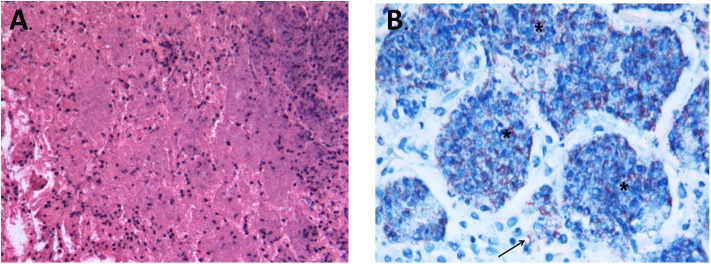
(A) Representative image of pulmonary necrosis in animals infected by strain 46P on day 28 postinfection. The image shows the complete loss of pulmonary tissue architecture over large areas, with cellular debris, picnotic and fragmented nuclei and acidophilic material occupying the extracellular space (200X magnification). (B) Ziehl-Neelsen stain showing specific necrotic areas with the presence of large ammounts of acid-fast bacteria within the necrotic tissue (*) but also free in the interstitial space (arrow) (1000X magnification; stained with Ziehl-Neelsen).